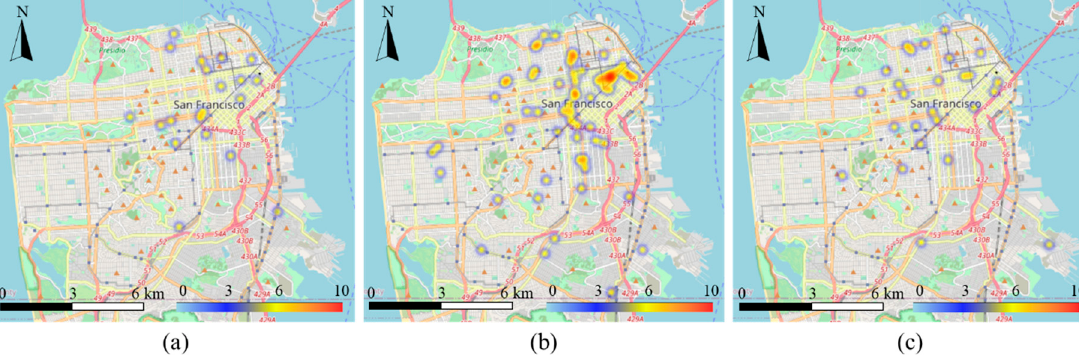
Figure 10. Hotspots of burglary in San Francisco, CA ( a ) 24 May 2020; ( b ) 31 May 2020; ( c ) 7 June 2020.